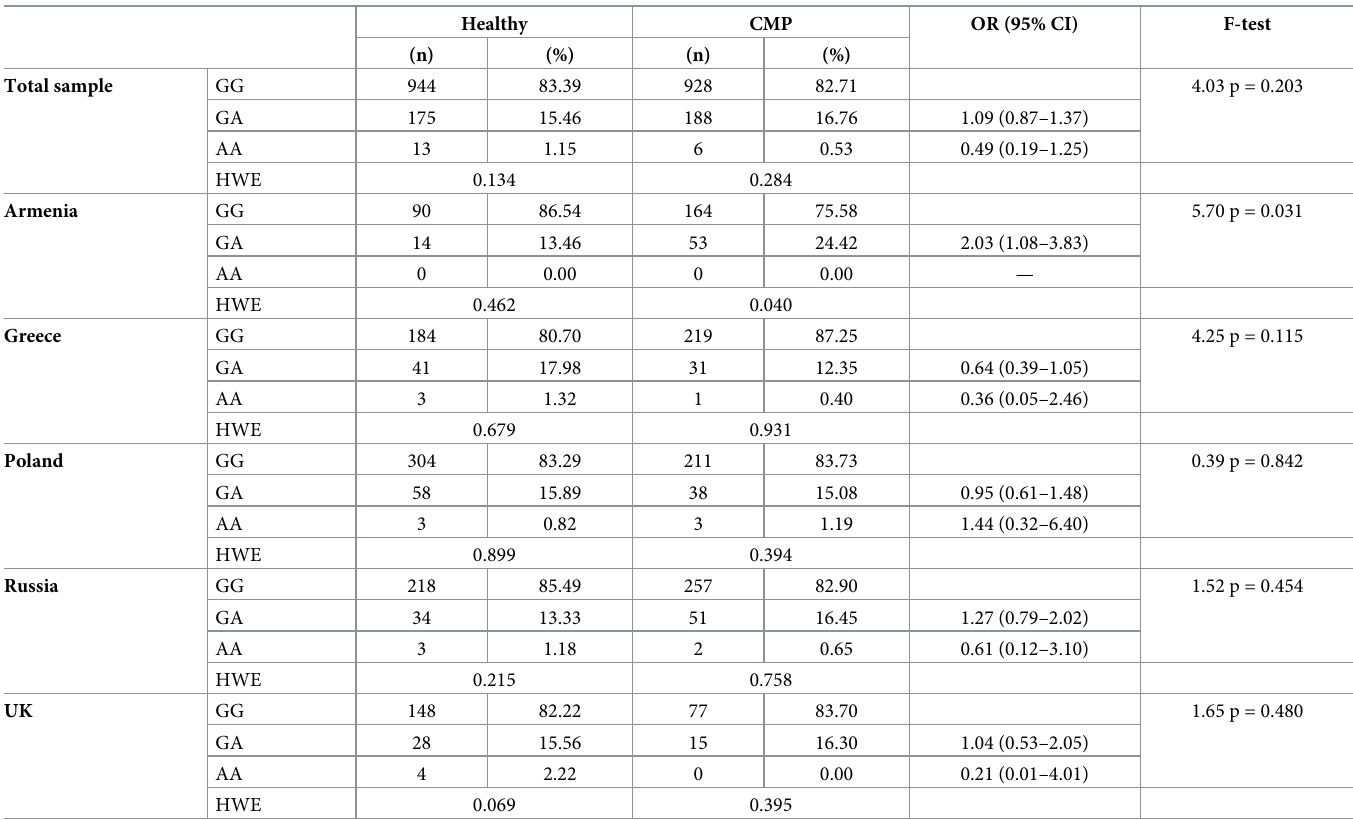
Table 2. Frequency of genotypes for Ala64Thr in CMP and healthy individuals.